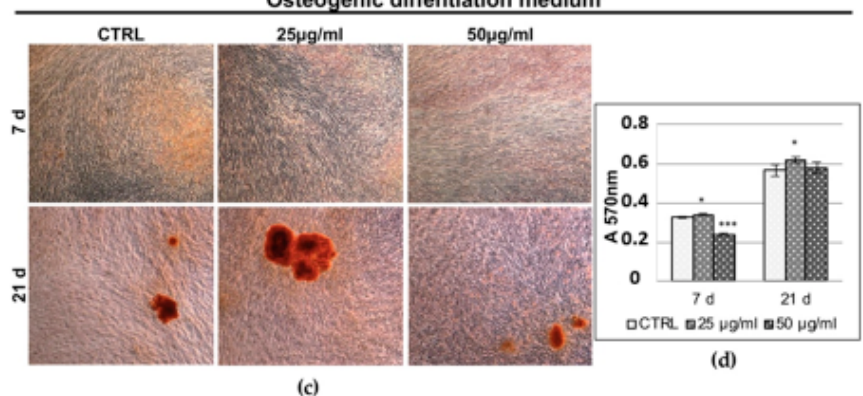
Figure 5. Alizarin red S (ARS) staining assay. ( a ) ARS assay in control ADSCs and ADSCs treated with 25 μ g/mL or 50 μ g/mL of YB at 7 and 21 d of culturing in basal medium. Magnification 20X. ( b ) Quantification of ARS assay in control ADSCs and ADSCs treated with 25 μ g/mL or 50 μ g/mL of YB at 7 and 21 d of culturing in basal medium. ( c ) ARS assay in control ADSCs and ADSCs treated with 25 μ g/mL or 50 μ g/mL of YB at 7 and 21 d of culturing in osteogenic differentiation medium. Magnification 20X. ( d ) Quantification of ARS assay in control ADSCs and ADSCs treated with 25 μ g/mL or 50 μ g/mL of YB at 7 and 21 d of culturing in osteogenic differentiation medium. * p < 0.05; ** p < 0.01; *** p < 0.001 vs. CTRL.